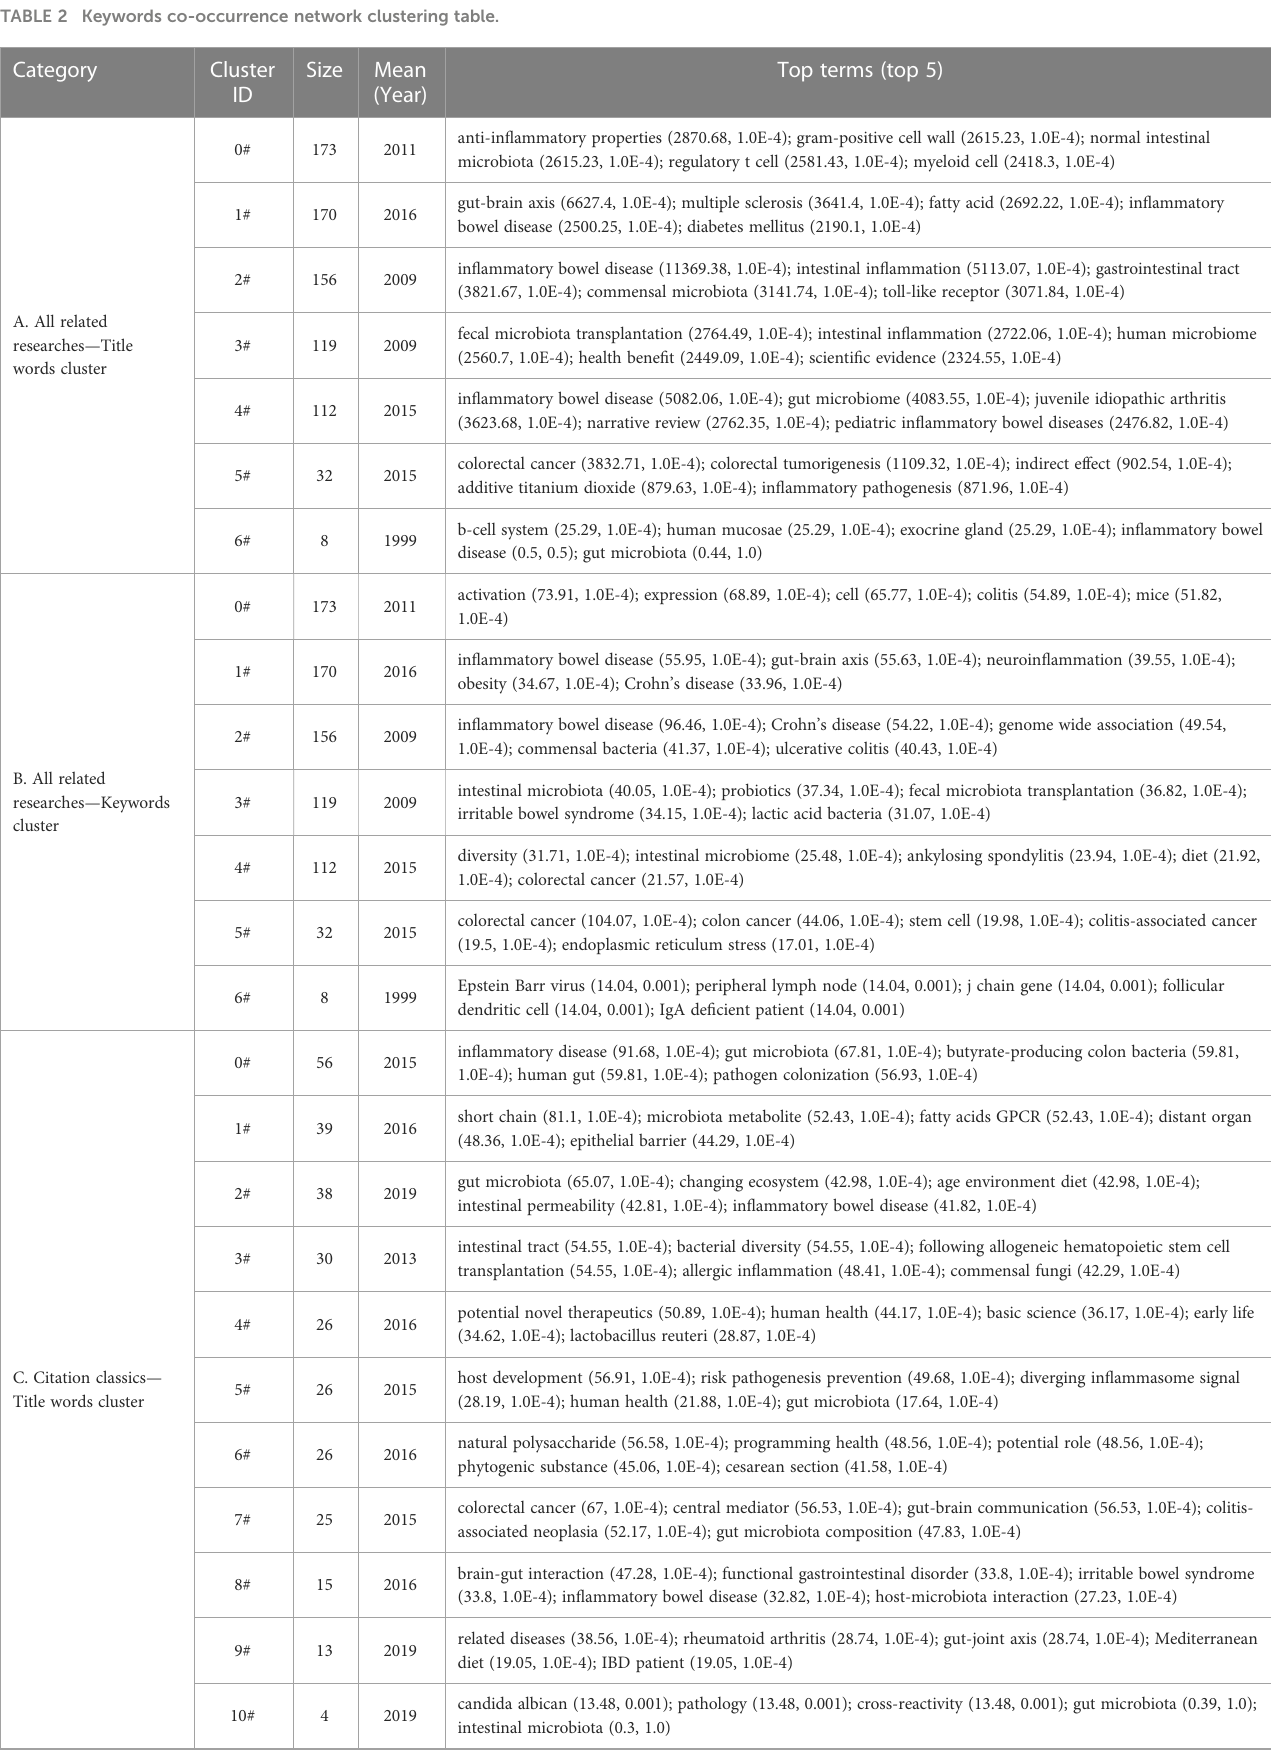
TABLE 2 Keywords co-occurrence network clustering table.